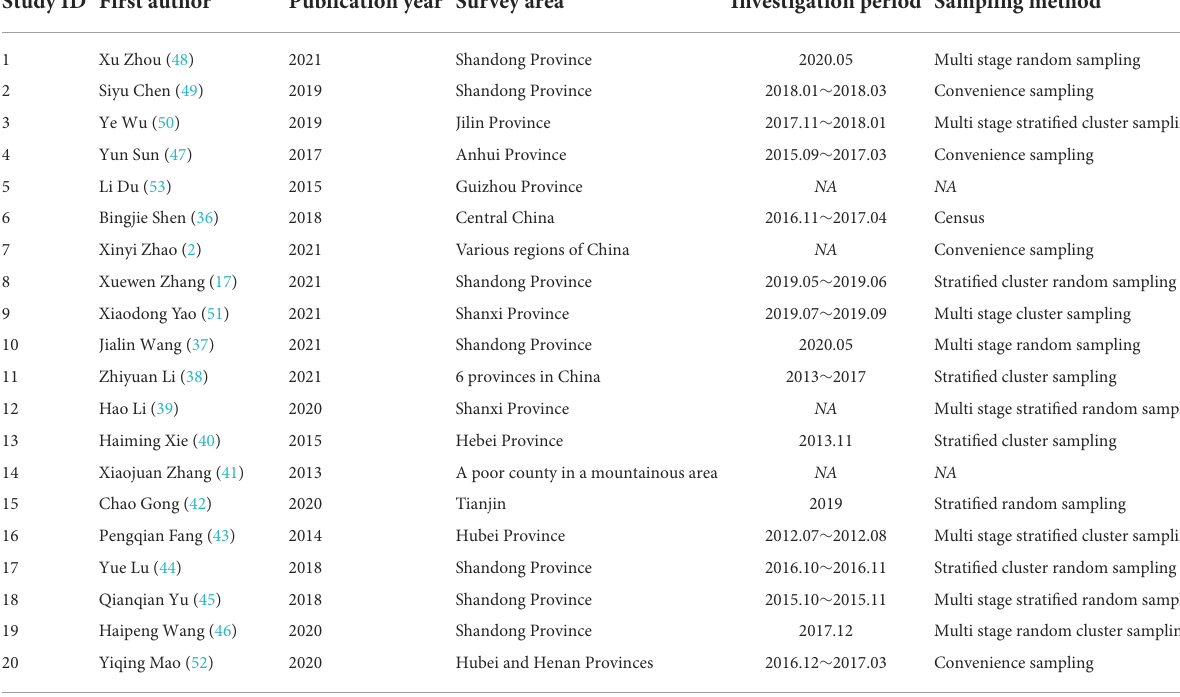
TABLE 1 A characteristic of 20 included studies of burnout and turnover intention among Chinese village doctors (VDs).